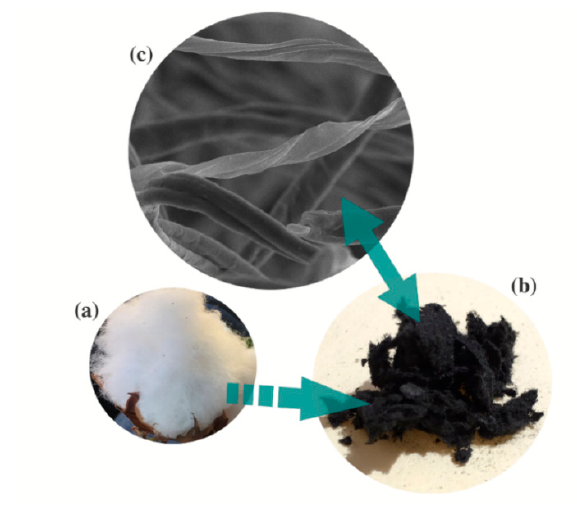
Figure 1. ( a ) Raw cotton; ( b ) Carbon fibers; ( c ) Scanning electron microscopy picture of carbon fibers where the fibrous structure is observable.